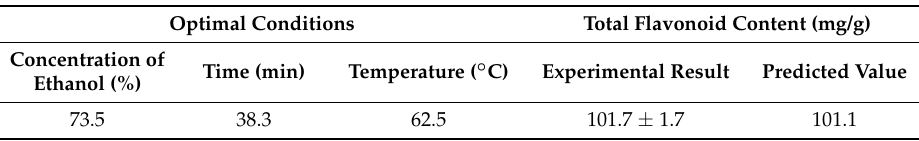
Table 3. The results of experimental